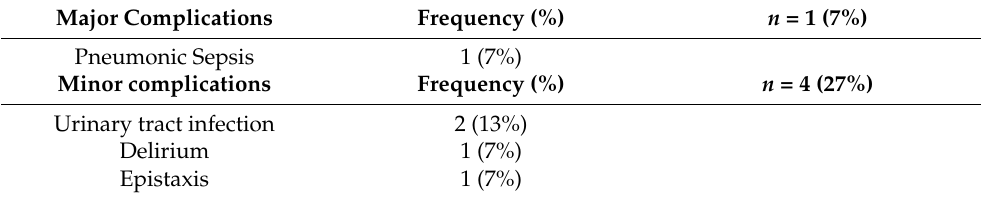
Figure 3. Preoperative and postoperative (after completion of the rehabilitation) improvement of the general and health care status, measured with the Barthel Index for each included patient. Table 4. Major and minor complications occurred in the early postoperative phase. One patient had major and minor complications. All patients recovered uneventfully.